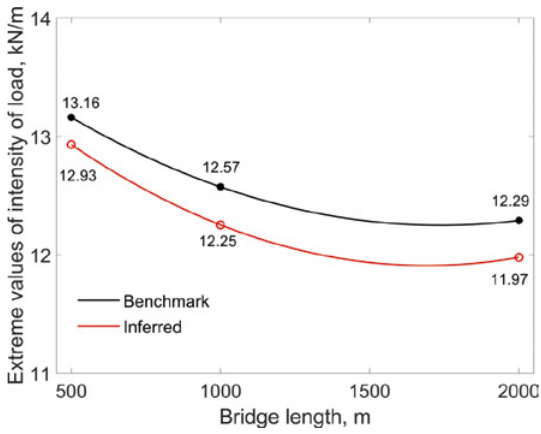
Figure 9. Extreme intensity of traffic load for the 75-year reference